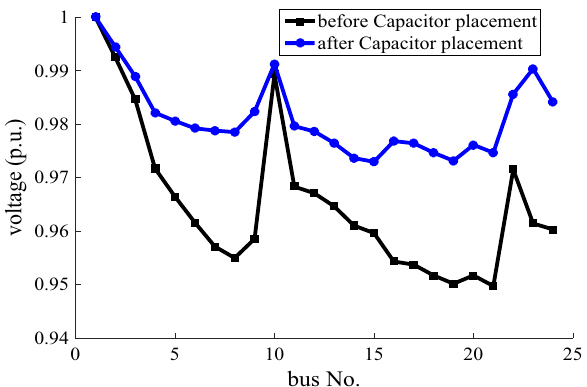
Figure 3. Voltage profile of 24-bus network in the grid-connected mode for the heavy load before and after capacitor placement, with cosφ = 1.